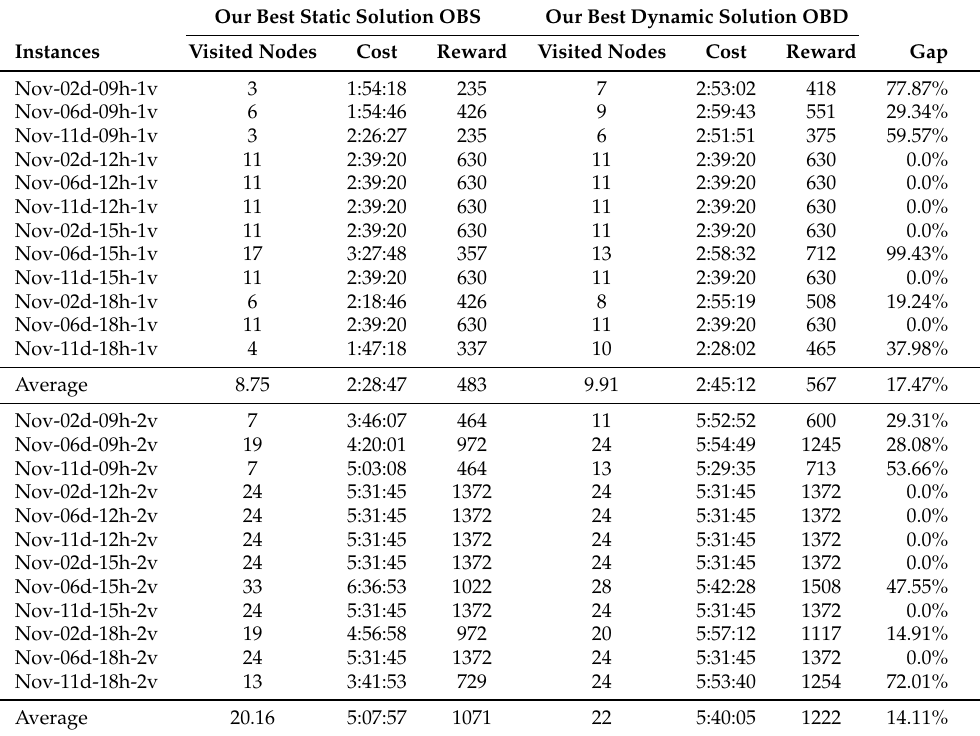
Table 2. Results for a case study considering different starting time and fleet